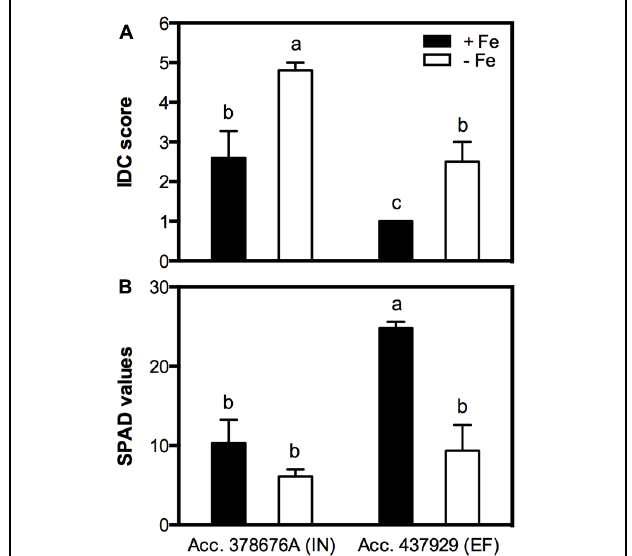
FIGURE 2 | Iron deficiency chlorosis (IDC) visual score (A) and Soil and Plant Analyzer Development (SPAD) values (B) in two Glycine max accessions [378676A (inefficient) and 437929 (efficient)] grown in Fe-sufficient ( + Fe) and Fe-deficient ( − Fe) hydroponic conditions. Data are the mean ± SE of five biological replicates. Different letters indicate significant differences ( P < 0.05).